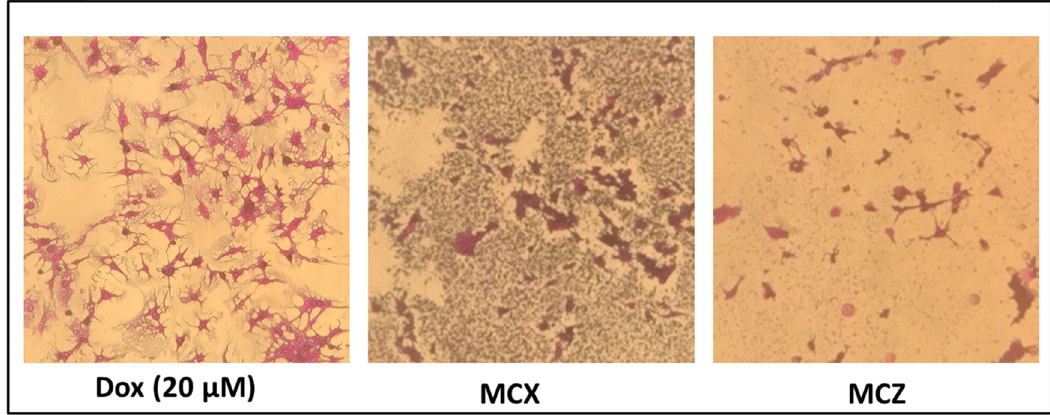
Figure 13: Cytotoxicity e ff ect of Doxorubicin 20 µM, MCX ( Ag - NPs ) , and MCZ ( ZnO - NPs ) on HepG2 cells after 24